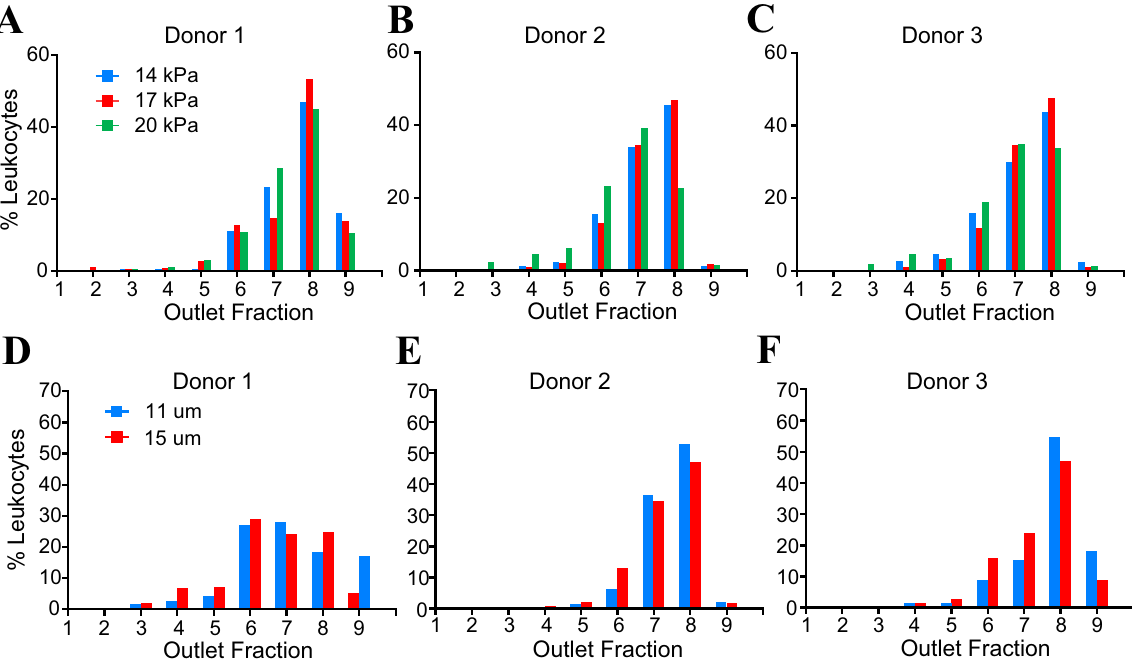
Figure 3. Leukocyte distribution at outlets as a function of filtration pressure applied at OSC2 and funnel thickness. ( A–C ) Leukocyte deformability profiles of three different donors at various filtration pressure with